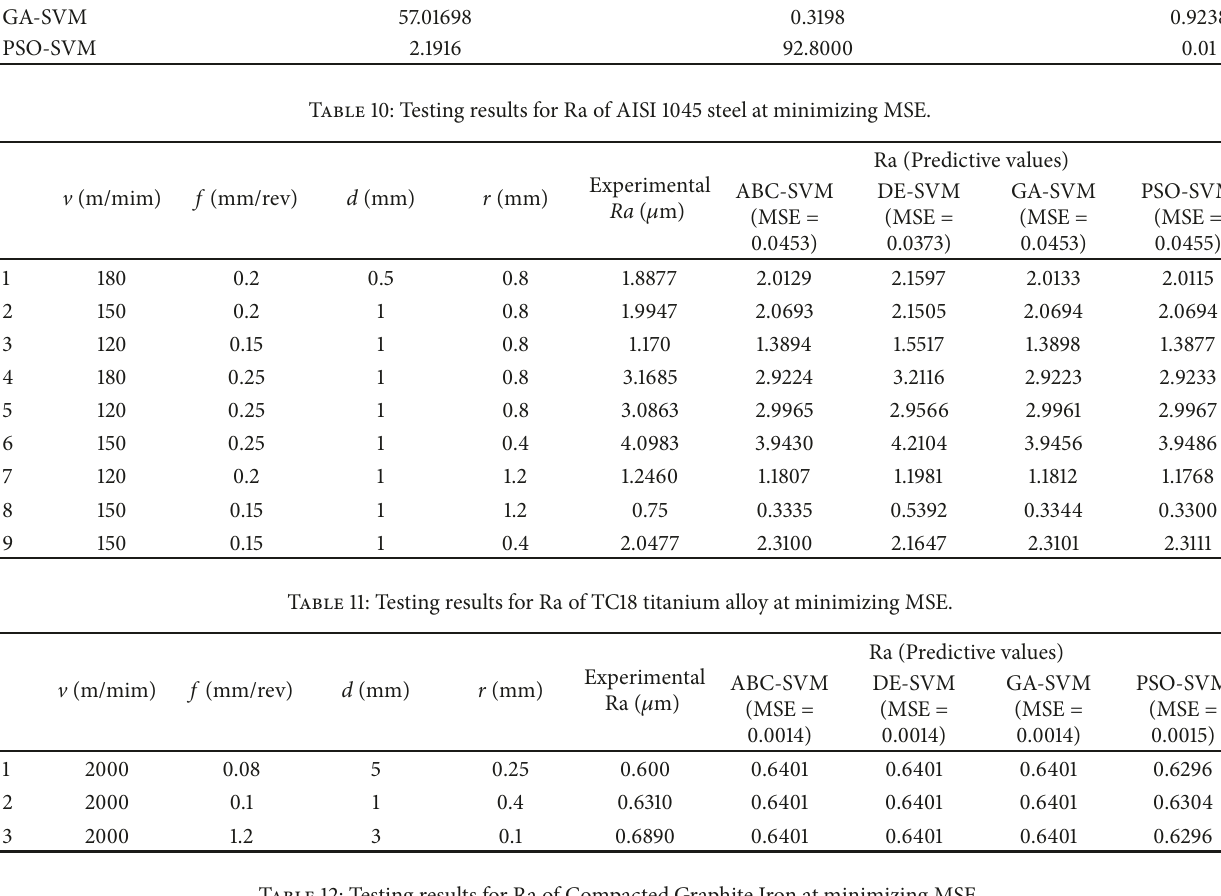
Table 12: Testing results for Ra of Compacted Graphite Iron at minimizing